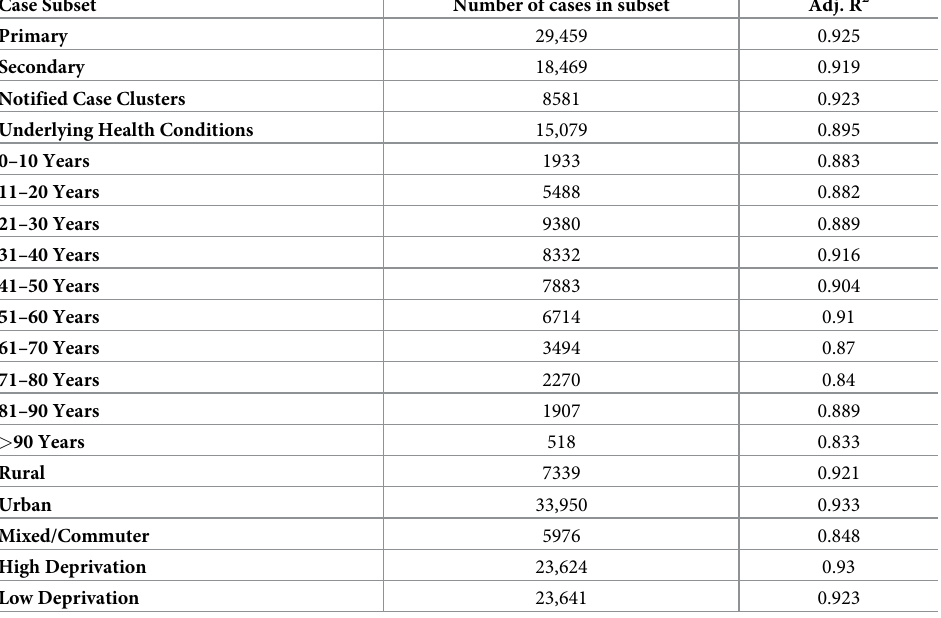
Table 3. Case subsets, associated sample number and results of breakpoint modelling (based on 5 breakpoints), N =